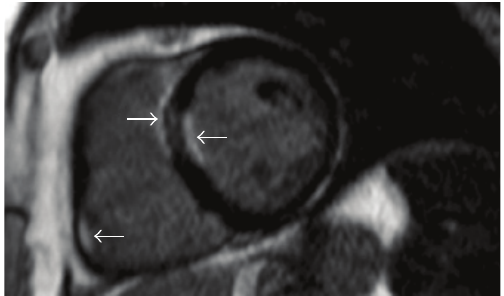
Figure 1: Gadolinium contrast-enhanced CMR scan; basal short- axis view demonstrating areas of hyperenhancement